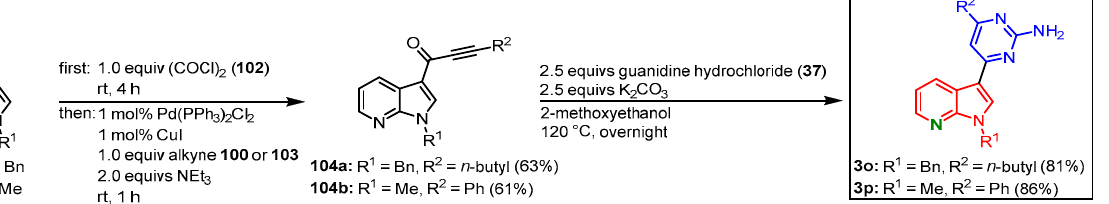
Figure 27. Synthesis of meriolins via three-component glyoxylation decarbonylative alkynylation by Merkul et al. [69].